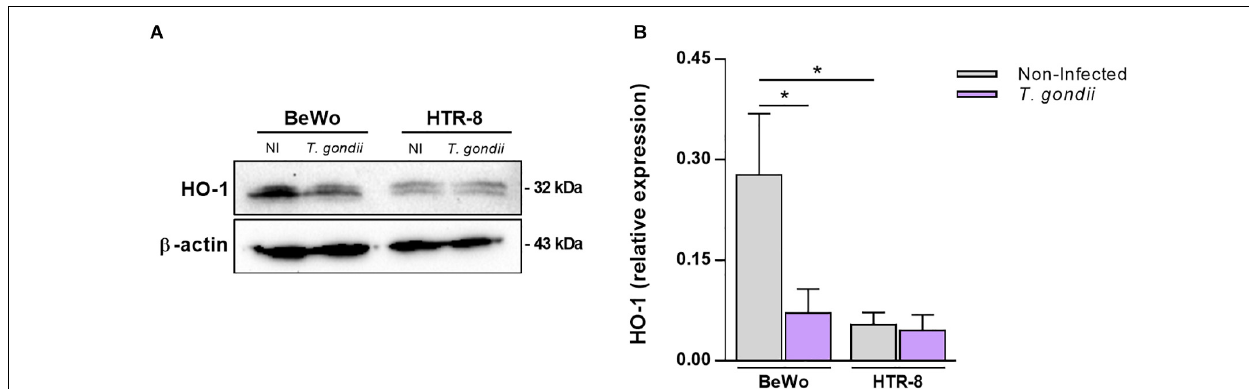
FIGURE 1 | Influence of Toxoplasma gondii infection in the HO-1 expression by BeWo and HTR-8/SVneo trophoblast cells. BeWo (1 × 10 6 cells/2,000 µ l/well) and HTR-8/SVneo (5 × 10 5 cells/2,000 µ l/well) cells were cultured in six-well plate during 24 h, infected or not (control) with T. gondii (1:1) for 3 h, and incubated with complete medium for additional 24 h. Cells were lysed, the total protein content were separated by electrophoresis, transferred to PVDF membranes, and submitted to western blotting assays for detection of HO-1 and β -actin. Protein bands were photodocumented, and densitometric analysis was performed by the ratio among HO-1 and its corresponding β -actin (endogenous control). (A) Representative blots for HO-1 and β -actin in the non-infected (NI) or infected ( T. gondii ) cell lines (cited as BeWo or HTR-8). (B) Densitometric analysis for HO-1 expressed as mean ± SEM from two independent experiments performed in six replicates. Significant differences were statistically assessed by the Mann-Whitney test; * P <